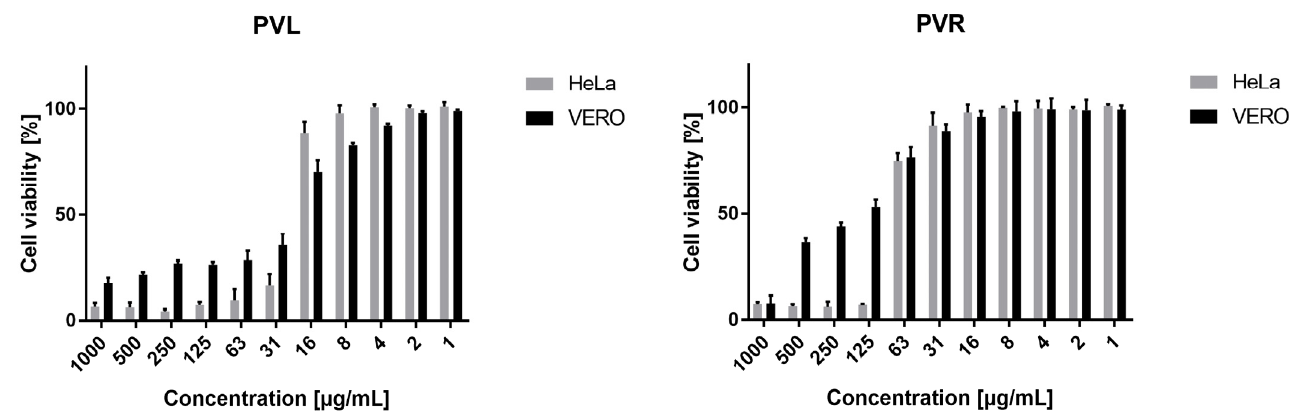
Figure 1. Cytotoxicity of P. vulgaris root (PVR) and leaf extracts (PVL) tested using MTT assay.